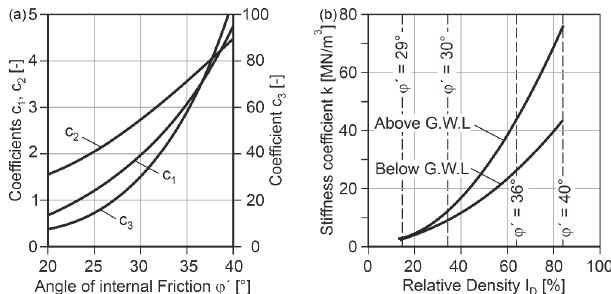
Figure 2. Coefficients C 1 , C 2 and C 3 (a) and parameter k (b) ac- cording to API